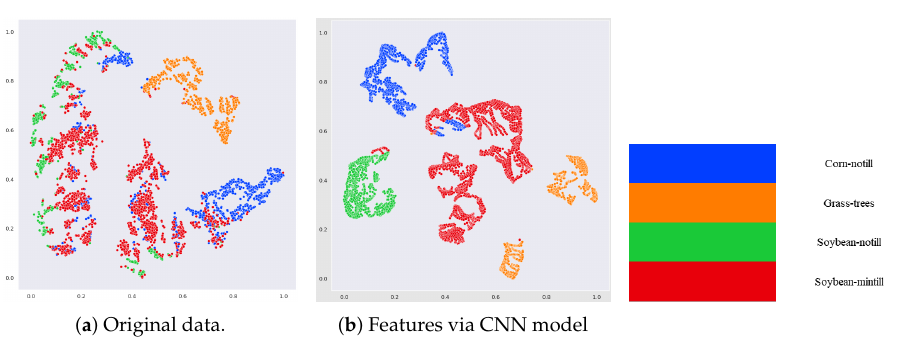
Figure 8. Visualization of data points of the Indian Pines dataset. Using t-SNE, we reduced the feature dimensionality to